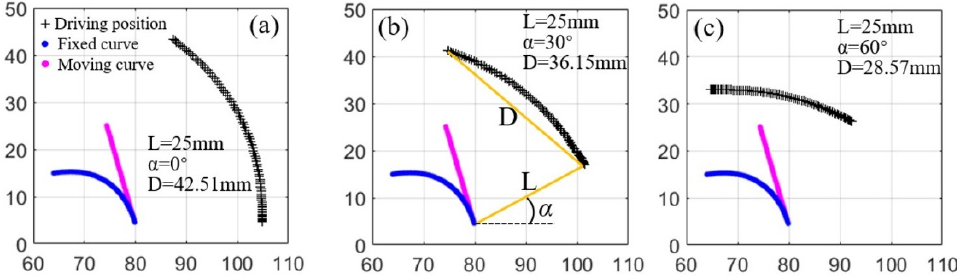
Figure 7. Three driving points at different positions for motion simulation. The initial position angles of α , ( a ) 0, ( b ) π /6, and ( c ) π /3.